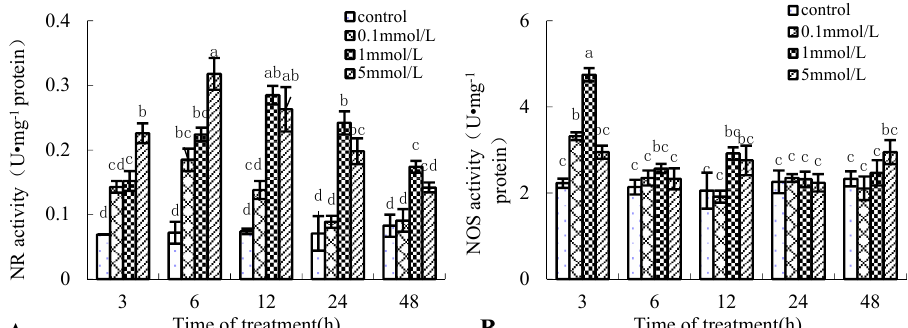
Figure 3. E ff ect of Put on enzyme activity of nitrate reductase (NR) and NO synthase (NOS) in suspension cells of birch. ( A ), NR activity in suspension cells of birch; ( B ), NOS activity in suspension cells of birch.